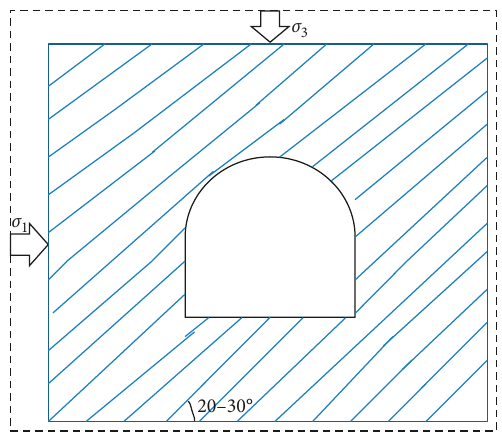
Figure 2: A geo-stress situation and bedded rock